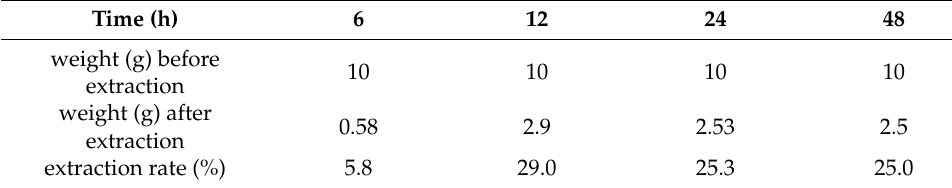
Figure 3. Extraction rate of P. emblica powders. Table 2. Extraction time and extraction rate for P. emblica